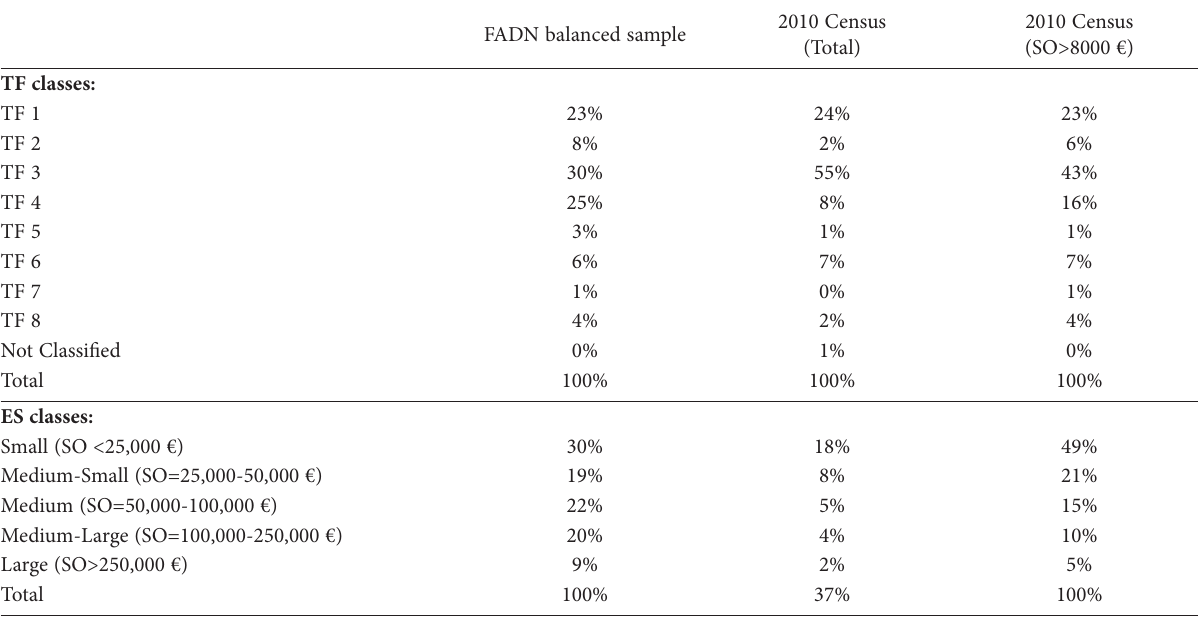
Legend: TF1 = Field crops; TF2 = Horticulture; TF3 = Permanent crops; TF4 = Grazing livestock; TF5 = Granivores; TF6 = Mixed crops; TF7 = Mixed livestock; TF8 = Mixed crops&livestock.